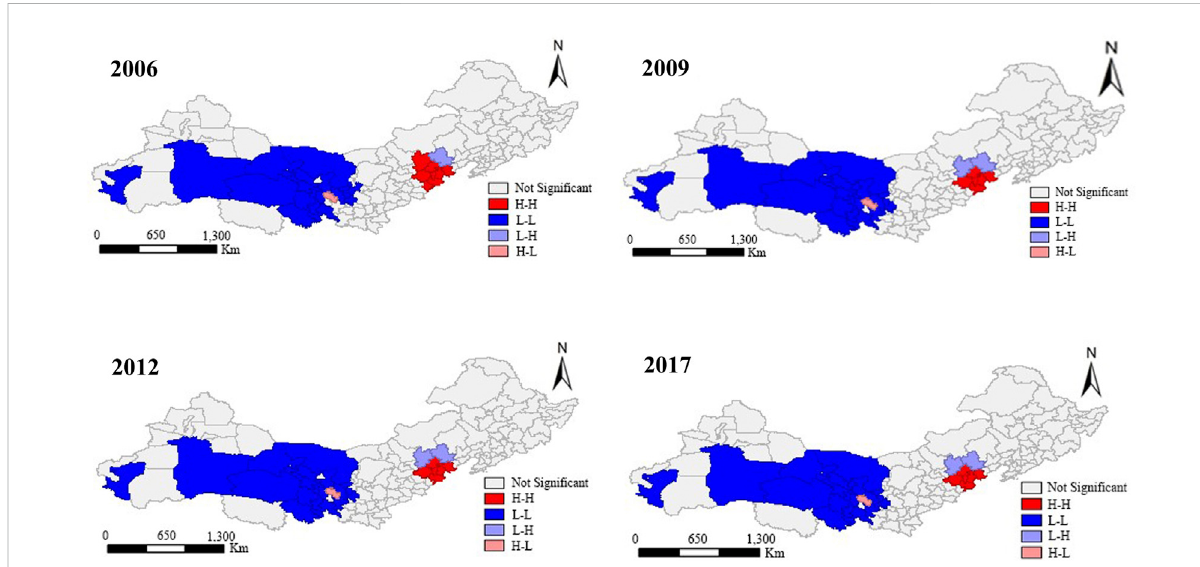
FIGURE 4 LISA Aggregation Map of GDP in the 13 Provinces of North China (2006 – 2017). Note: H – H, L – L, L – H, and H – L represent high – high, low – low, low – high, and high – low aggregation,